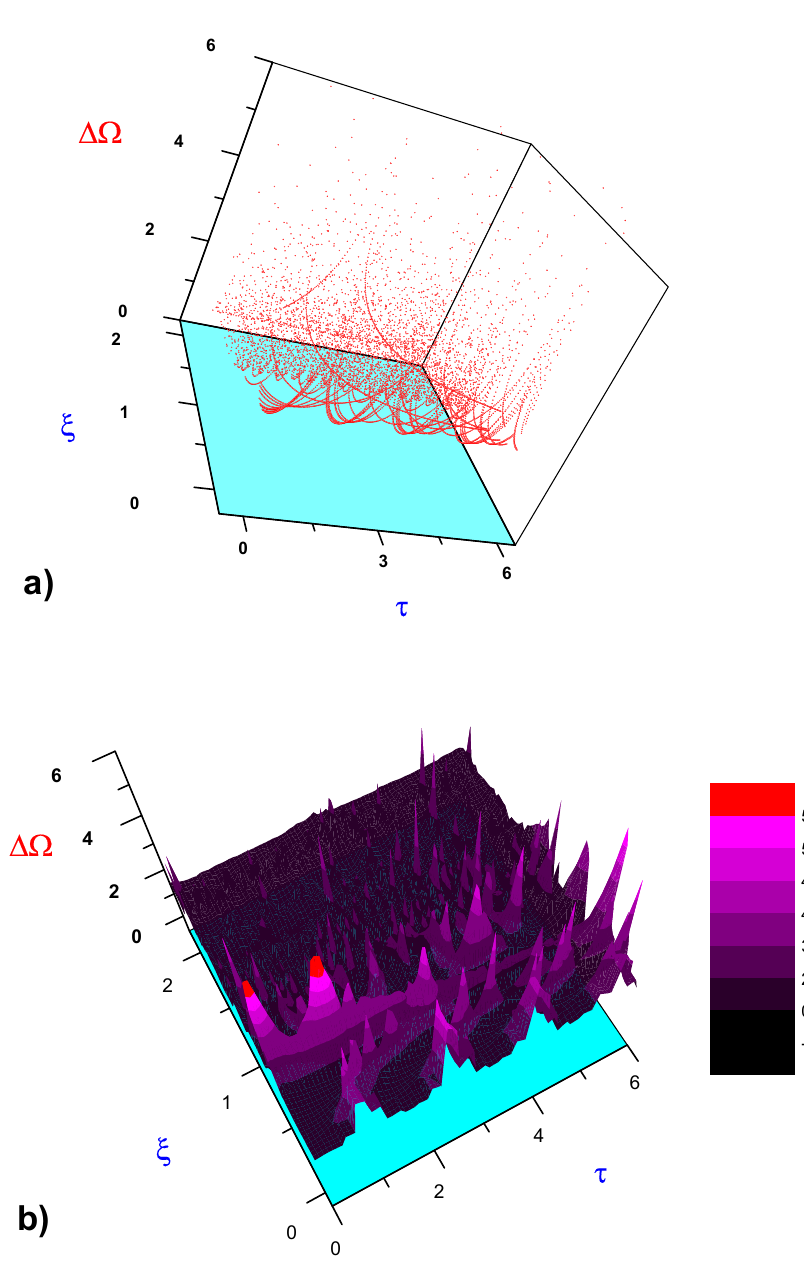
Figure 7. for S = – 1 S = – 1 S = – 1 in Eqs. (65 and 66) shows some features of ∆Ω∆Ω∆Ω propagation in the plane ( ξ , τ )( ξ , τ )( ξ , τ ) . It is observed both in the panel (a) in the form of scattered points, and in the level surface of the panel (b) that there are patterns of intense peaks regularly spaced. It is also noted that for ξ ≈ 1 ξ ≈ 1 ξ ≈ 1 there is a rather extensive barrier of these intense peaks around these intermediate